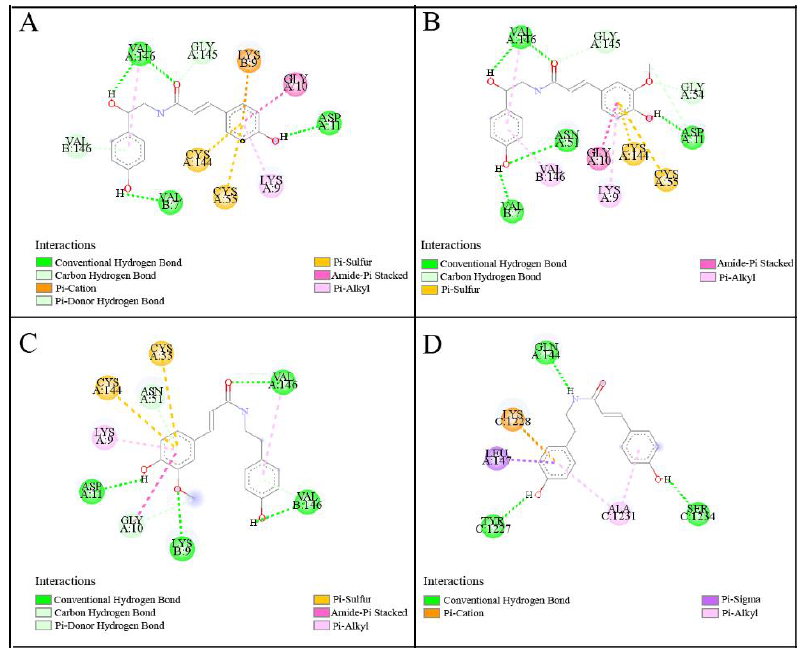
Figure 5. Docking models of screened ligands with SOD and XOD: ( A ), SOD- N - trans - p -coumaroyloctopamine; ( B ), SOD- N - trans -feruloyloctopamine; ( C ), SOD- N - trans -feruloyltyramine; ( D ), XOD- N - cis - p -coumaroyltyramine, respectively.